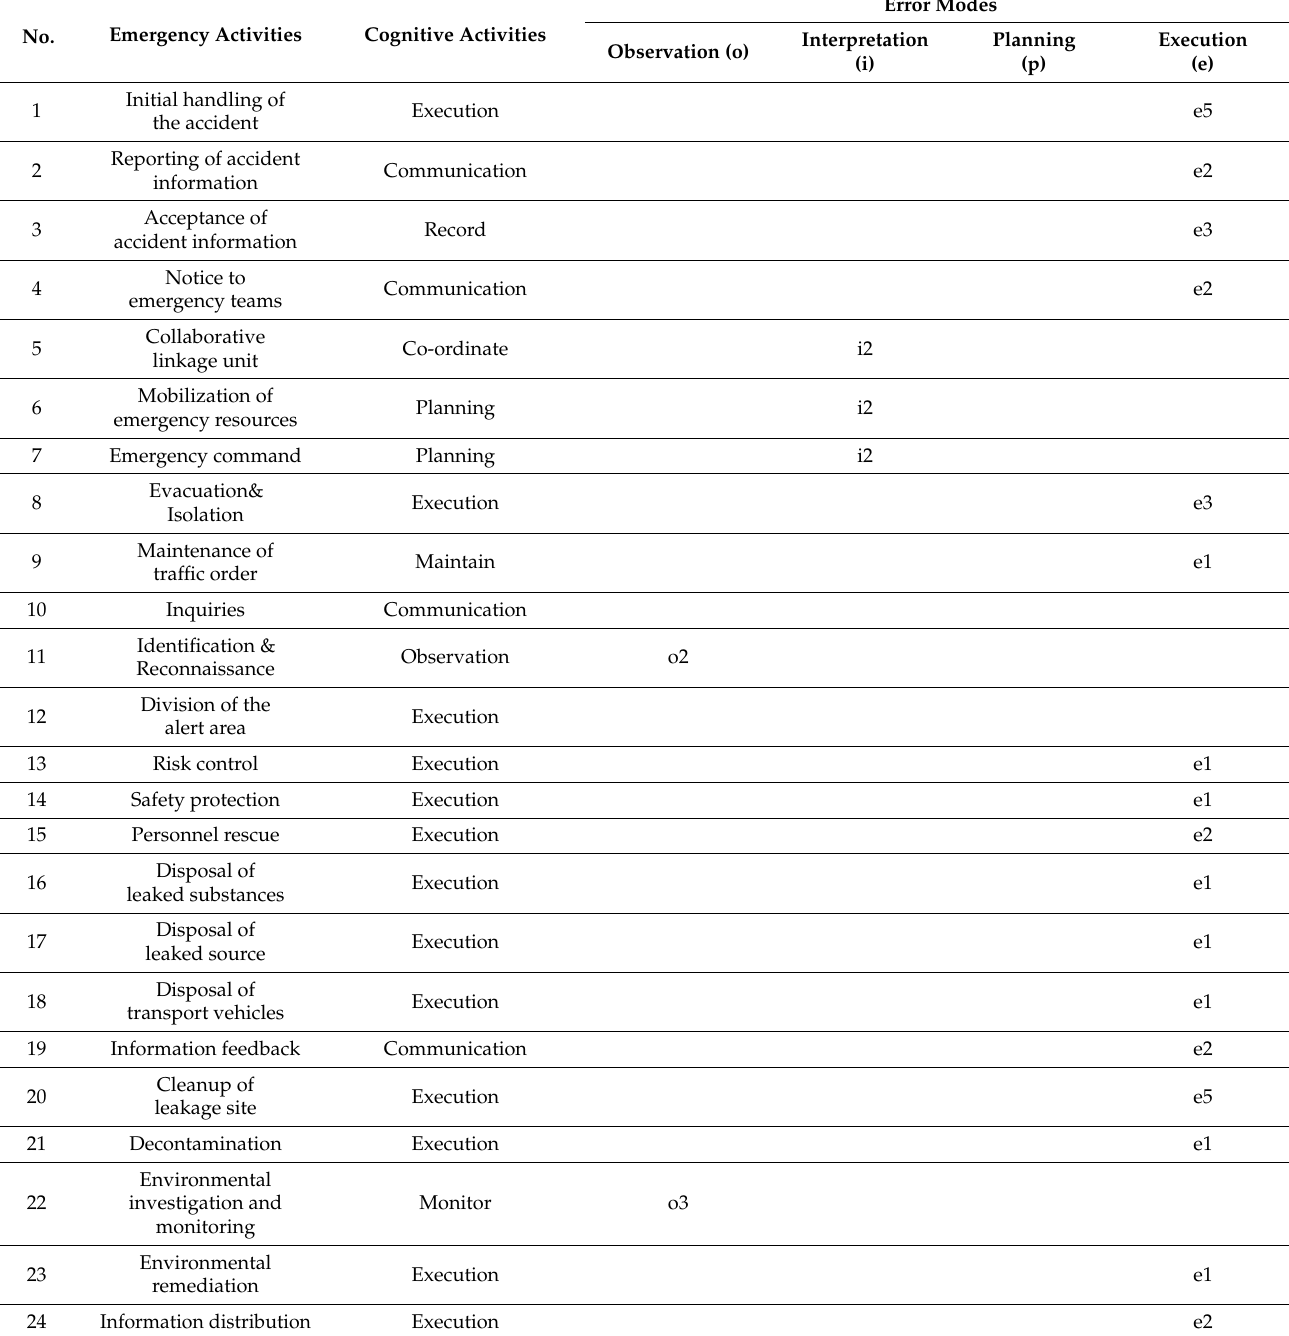
Table 4. Emergency activities, cognitive activities and error